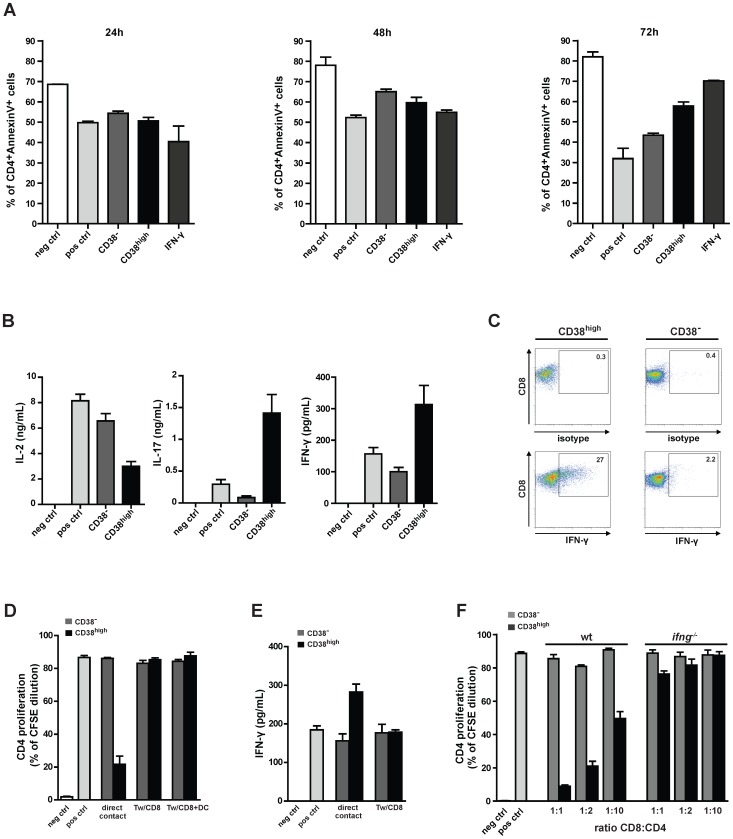
CD8+CD38high T cells are suppressive in vitro, their activity is dependent on IFN-γ secretion and requires cell-to-cell contact.1×105 CD4+ OTII T cells were stimulated with (pos ctrl) or without (neg ctrl) OTII323–339 peptide in the presence of DCs. CD8+CD38high (CD38high) or CD8+CD38− (CD38−) T cells were added to the culture at a ratio 1∶1 (1×105 cells) (A-E). (A) Apoptosis of CD4+ OTII T cells was measured by annexinV/PI staining. The percentage of CD4+ annexinV+ T cells is shown at indicated time points of co-culture with CD8+ T cells or in the presence of 100 ng/ml of IFN-γ (IFN-γ). The assay was performed in triplicates and shown is the mean±SEM. Results are representative of three independent experiments. (B) Concentrations of IL-2, IL-17 and IFN-γ in supernatants of 72 h co-cultures were measured by ELISA and the mean±SEM of one of three independent experiments is shown. (C) CD4+ OTII T cells were stimulated with OTII323–339 peptide in the presence of DCs. Either CD8+CD38high (CD38high) or CD8+CD38− (CD38−) T cells were added to the culture at a CD8:CD4 ratio of 1 for 48 h. The last 6 h of incubation brefeldin (10 µg/mL), ionomycin (1 µg/mL) and PMA (100 ng/mL) were added to the co-cultures. Cells were stained with CD8 mAbs, fixed and intracellularly stained with IFN-γ mAbs or isotype matched control Abs. CD8+ T cells were gated and plots represent the expression of IFN-γ in CD38high or CD38− T cell populations. Numbers represent percentage of cells in the indicated gate from one representative experiment of two performed. (D) CD4+ OTII T cells were stimulated without (neg ctrl) or with (pos crtl) OTII323–339 peptide in the presence of DCs. Either CD8+CD38high (CD38high) or CD8+CD38− (CD38−) T cells were added directly (direct contact) to the culture at a CD8:CD4 ratio of 1. CD4+ OTII T cells, DC and OTII323–339 peptide were placed in the lower chamber of the transwell, CD38high or CD38− T cells (Tw/CD8) or CD38high or CD38− T cells together with DCs (Tw/CD8+DC) were given into the upper chamber of the transwell (at a CD8:CD4 ratio of 1). (D) Antigen-specific proliferation of CD4+ OTII T cells was measured by CFSE dilution after four days of incubation. (E) IFN-γ concentration in the supernatants was measured by ELISA. Assay was performed in triplicates and the mean±SEM of one representative of three independent experiments is shown. (F) CD4+ OTII T cells were incubated with DCs with (pos ctrl) or without (neg ctrl) OTII323–339 peptide. CD8+CD38high (CD38high) and CD8+CD38− (CD38−) T cells sorted from C57Bl/6j wt or ifn-γ
−/− mice were added to the culture at the indicated CD8:CD4 ratios. The proliferation of CD4+ OTII T cells was measured in triplicates by CFSE dilution after four days of culture. The mean±SEM of one of two independent experiments is shown.